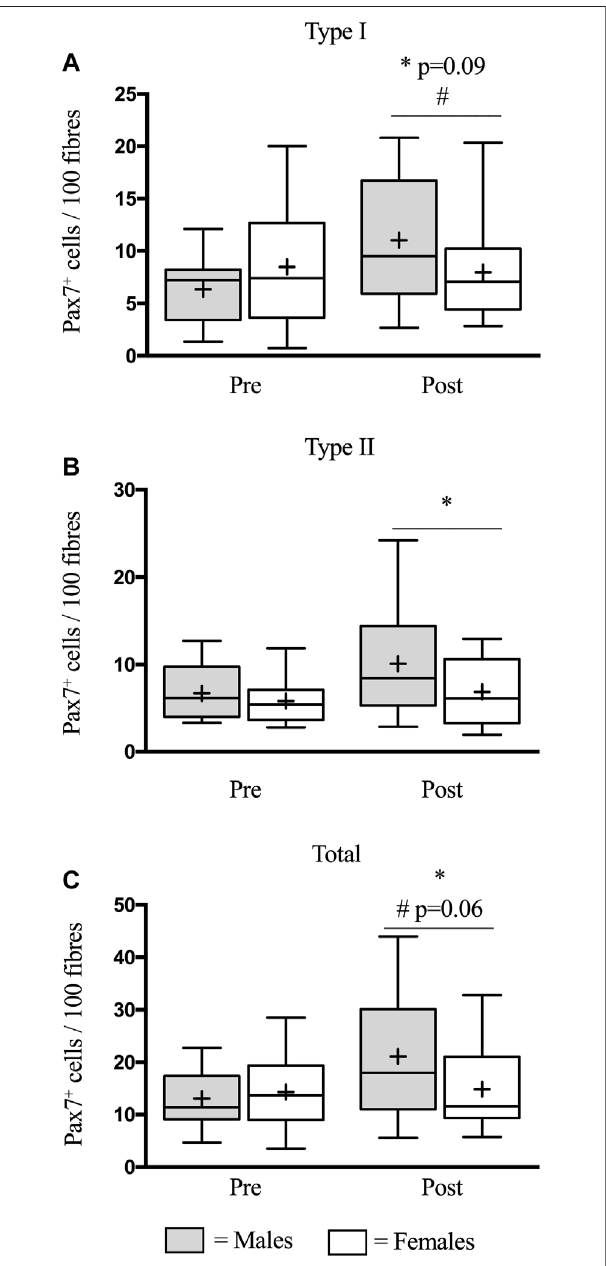
FIGURE1| Meannumberofsatellitecells(SCs)permuscle fi breintypeI (A) ,typeII (B) ,andtotal (C) muscle fi bresbefore(pre)and48 h(post)following eccentric damage. The box-and-whisker plot displays the median (line) and the mean (+), with the box representing the interquartile range (IQR), and the whiskers representing the maximum and minimum values. * indicates a signi fi cant effect of time ( p < 0.05). # indicates time × group interaction.